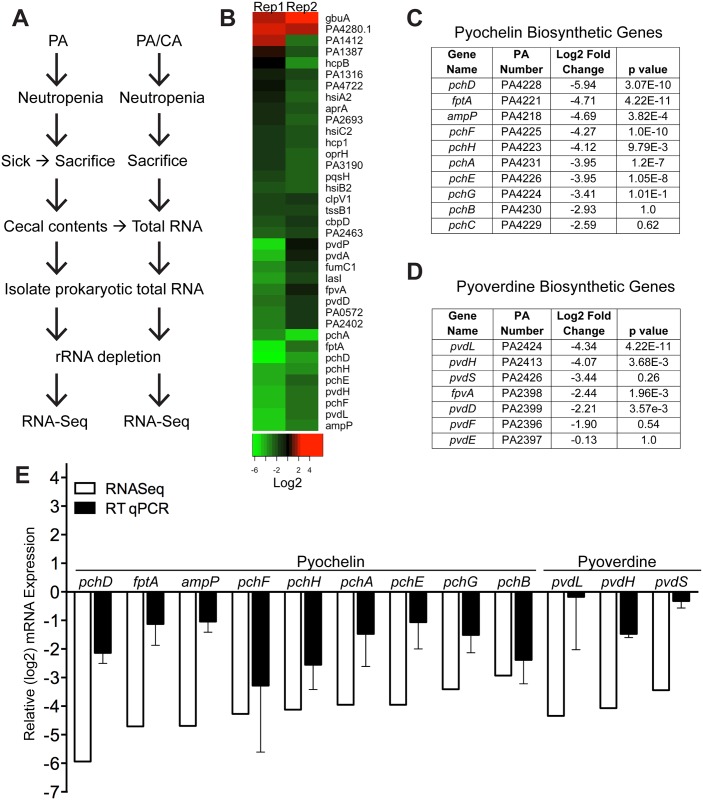

C. albicans suppresses pyochelin and pyoverdine biosynthetic pathways in P. aeruginosa.
A) Experimental schema of in vivo P. aeruginosa transcriptome analysis experiments. PA, P. aeruginosa. CA, C. albicans. B) Heatmap of RNA-Seq analysis of P. aeruginosa strain PAO1 transcripts recovered from cecums of neutropenic mice co-colonized with P. aeruginosa and C. albicans compared to mice mono-colonized with P. aeruginosa. Prokaryotic mRNA from 8 mice pooled for each biological replicate; 2 biological replicates performed. RNA-Seq analysis performed with DESeq. C, D) Summary tables of P. aeruginosa pyochelin (C) and pyoverdine (D) gene expression (data from RNA-Seq analysis). E) RT qPCR of P. aeruginosa pyochelin and pyoverdine biosynthetic genes (performed on the same RNA samples used for RNA-Seq analysis). All data shown are means ± SEM. Assays were performed in triplicate. Statistical analysis was performed by unpaired Student’s t-test. * p< 0.05; ** p<0.01; ns, not significant.